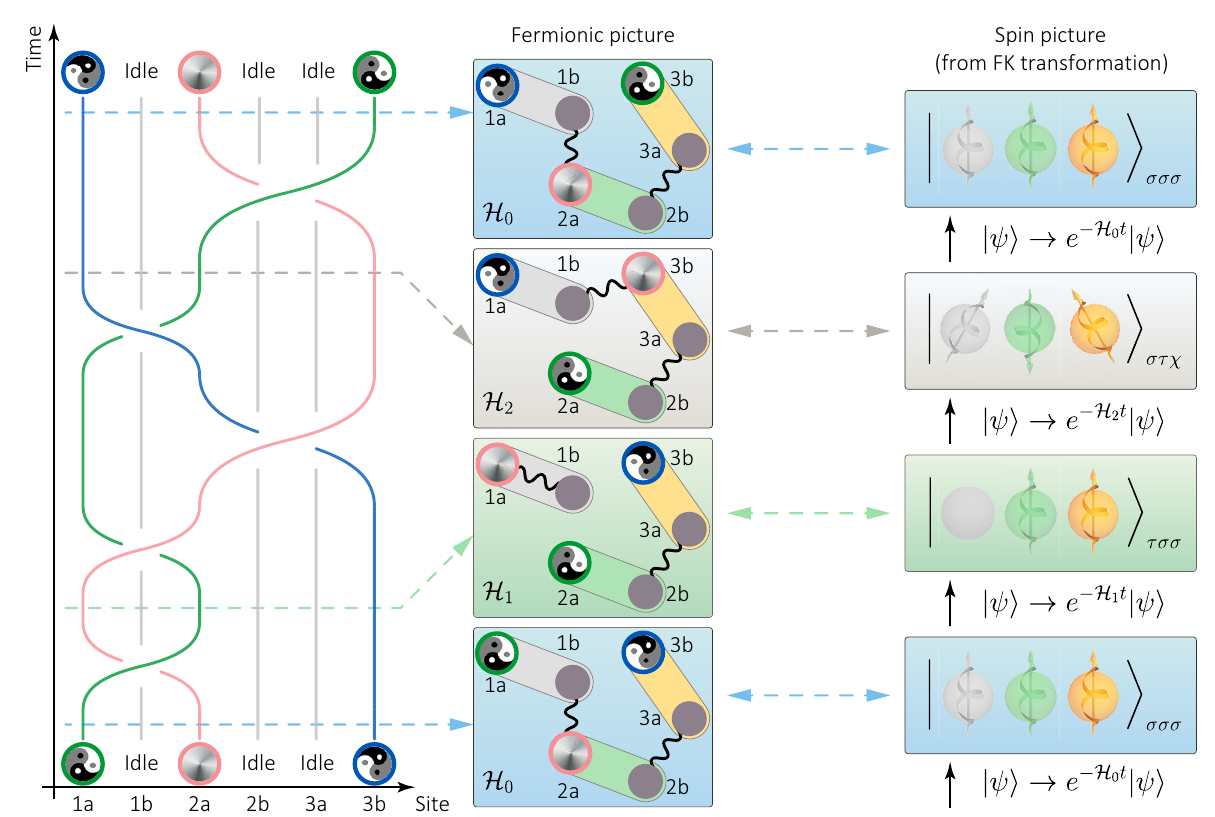
FIG. 1. The braiding of parafermion-edge zero modes. Left: the braiding of two parafermion-edge zero modes located on the two remote sites of a parafermionic chain using an auxiliary parafermionic site. The taichi symbols with green and blue edges denote two parafermion-edge zero modes, the silver disk with pink edge denotes the auxiliary parafermion, and the solid disks denotes idle parafermionic sites that do not participate in the braiding procedure. The braiding operation yields a Clifford gate on the encoded parafermion qutrit. Middle: the physical realization of the braiding operation on an interacting parafermion chain. By adiabatically , H Pf , H Pf and again H Pf [see Eqs. 1 and (2)], the system evolves to different configurations that tuning the system Hamiltonian to H Pf 0 1 2 0 result in two parafermion-edge zero modes being exchanged. Note that between H 1 and H 2 the green parafermion undergoes a type-2 Reidemeister move that does not affect the braiding process. The curly lines denote the interaction between different sites and the rounded rectangles pair the parafermions that belong to a single site. Right: application of the Fradkin-Kadanoff transformation on the chain yields a spin-1 quantum Potts model with Z 3 symmetry. Its evolution can be effectively simulated by a series of imaginary-time evolution that repeatedly project the system onto the ground state of new Hamiltonians. In each subpanel, the spin states corresponding to the empty sphere have an eigenvalue of 1 on the basis denoted as a subindex of the ket symbol, the spheres with upright arrows have the same eigenvalues, and the spheres with tilted arrows have spin eigenvalues that sum up to the sphere with inverted arrow [modulo 3; see the definition of the eigenstates following Eq. (3)]. The dashed horizontal lines link the configurations in the three different pictures at each stage of the